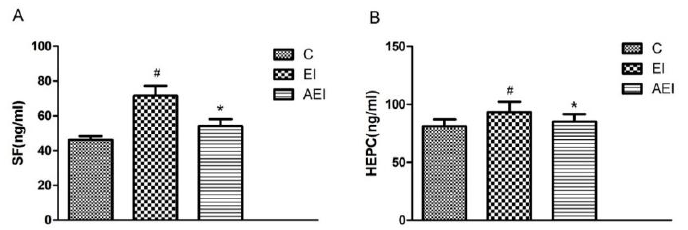
Figure 2. Effects of aplysin on serum ferritin (SF) and hepcidin (HEPC). ( A ) The serum ferritin in rats. ( B ) The serum hepcidin in rats. C: Control Group; EI: Ethanol and Iron Group; AEI: Aplysin (150 mg kg −1 ) with Ethanol and Iron Group. # p < 0.05 versus C group, * p < 0.05 versus EI group.